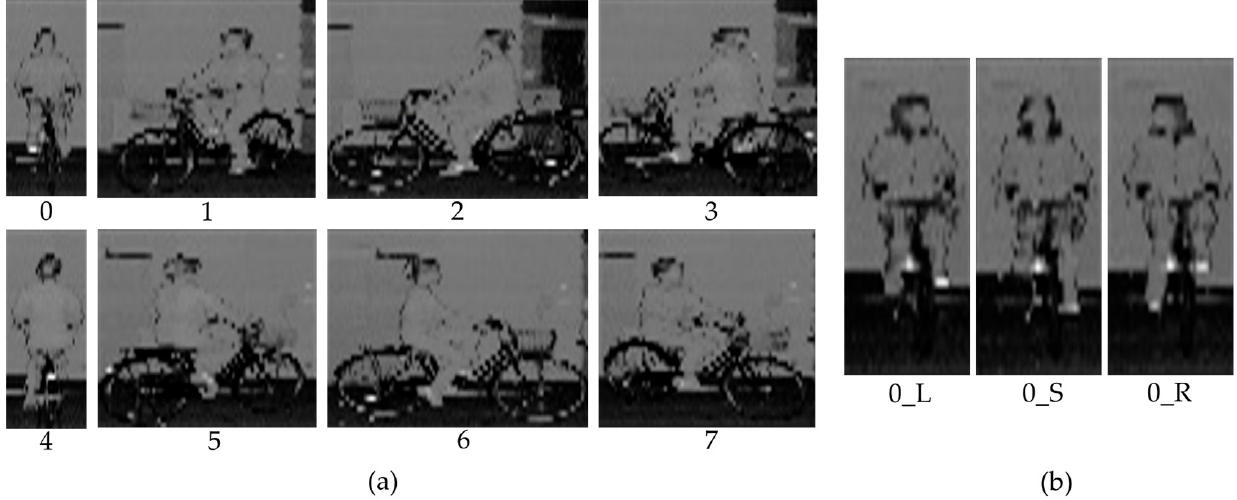
Figure 3. Reflectivity images of cyclist with different body orientations ( a ) and head orientations ( b ). (In addition to the reflectivity information, ambient and range are also used in 2D image-based cyclist orientation estimation).